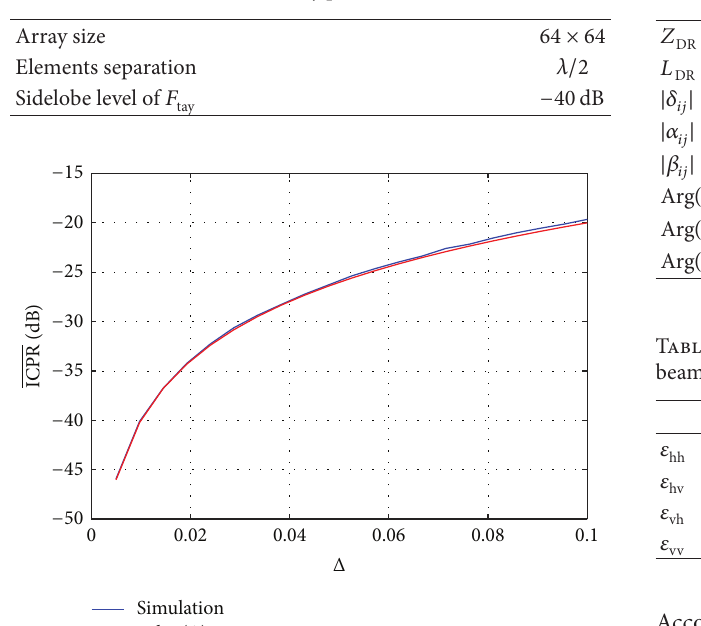
Table 1: Array parameters.